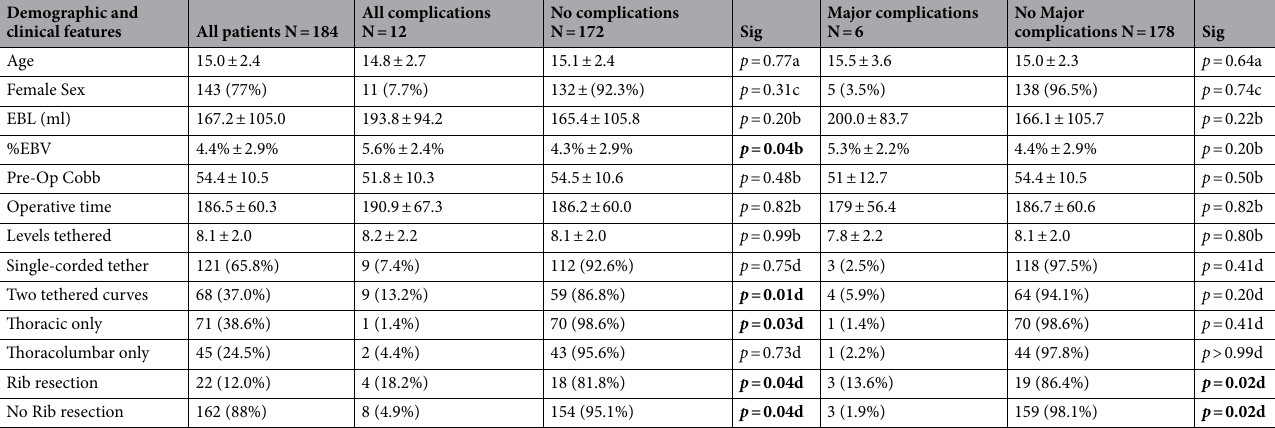
Table 1. Demographic and clinical features divided by complications. Significant values are in [bold]. a = Student’s T-test. b = Mann–Whitney. c = Chi Square. d = Fisher’s Exact. e =